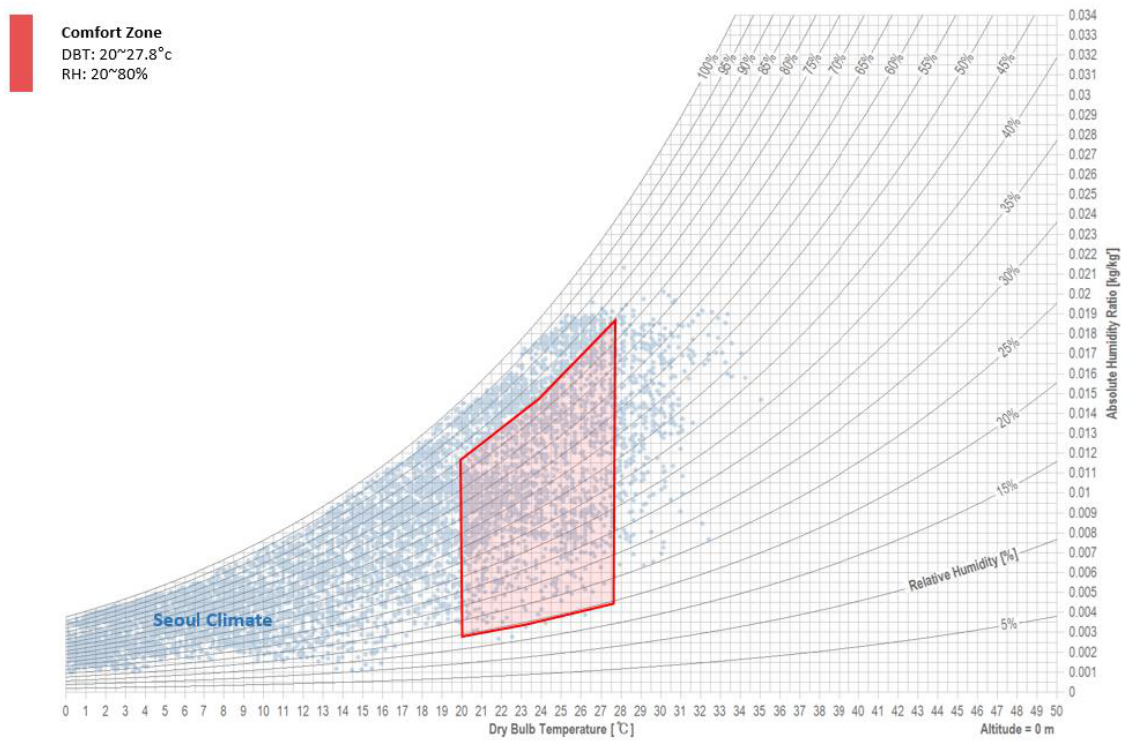
Figure 3. Annual temperature and relative humidity in Seoul, Korea.